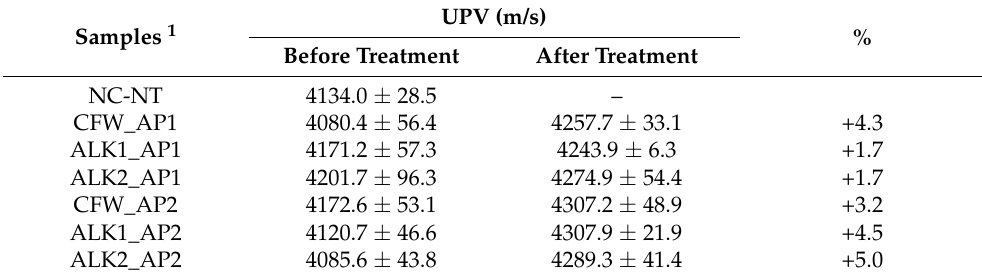
Table 3. UPV values for uncracked–untreated and for cracked samples, before and after treatment.